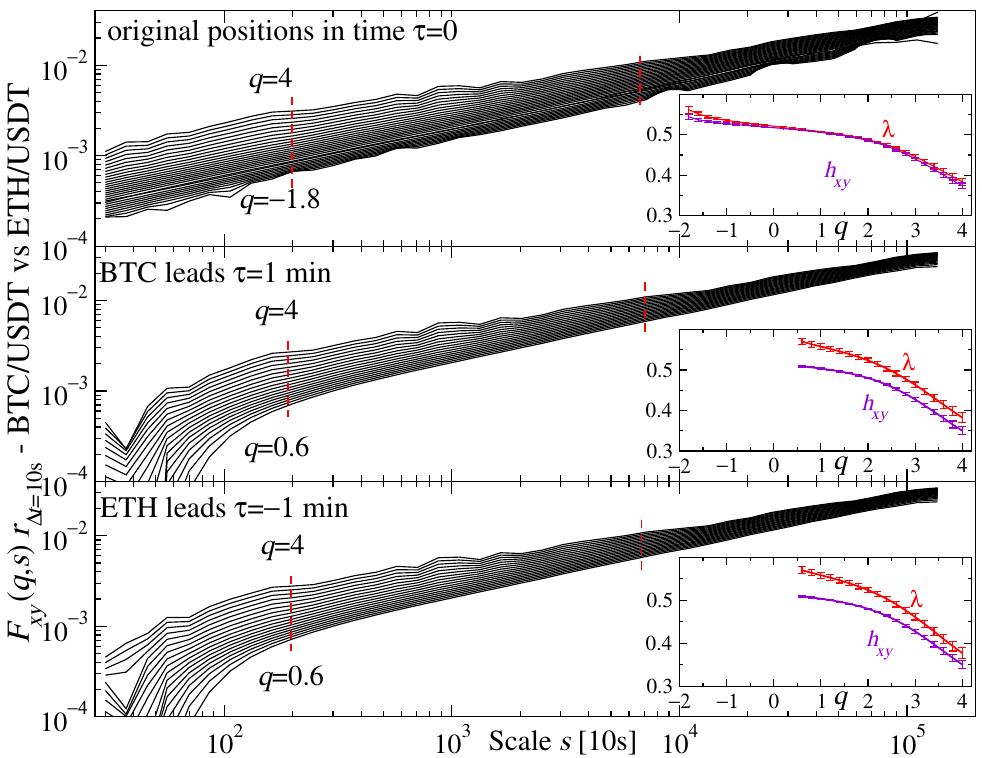
Figure 4. ( Main panels ) Fluctuation functions F XY q ( s ) calculated for the time series of logarithmic price returns r ∆ t ( t ) for X = BTC and Y = ETH. In each panel, vertical dashed lines denote a range ( s ) . Extreme values of q are also of time scales s for which a power-law model can be fitted to F q XY shown. Three cases are considered: both time series are simultaneous ( top ), time series representing BTC is advanced by τ = 1 min ( middle ), and time series representing ETH is advanced by τ = 1 min ( bottom ). ( Insets ) The bivariate scaling exponent λ ( q ) vs. the mean univariate scaling exponent h XY ( q ) calculated for the same time series. Error bars denote the standard errors. ( s ) for the time series that are The middle and bottom panels of Figure 4 present F XY q shifted relative to each other by τ = 1 min: either BTC leads by τ (middle) or ETH leads by τ (bottom). In both cases, we see similar power-law dependence over ∼ two decades, but for larger s than in the τ = 0 case. We consider this shift toward longer s as expected, because asset prices need time to build up the cross-correlations if they are weakened by the relative shifts. The bivariate and mean univariate scaling exponents shown in the insets reveal a gap between them that is largest for q < 1, while if q increases, both quantities gradually converge. Compare this with Figure 5b (top panel, green and red lines) for even better visibility. The plots for τ = 0 and τ = ± 1 clearly differ from each other: for the shifted time series, ρ q ( s ) is more variable than for the simultaneous ones. However, what is similar is that here, ρ q ( s ) also shows steeper growth for q = 2 than for q = 4—see Figure 5a (top panels, green and red lines). For q = 2, there is no visible difference between the results if either BTC or ETH leads (top left). This changes after we move to higher q s: for q = 4 there is a noticeable difference between the corresponding lines, with higher values of ρ q ( s ) if BTC leads. This difference, however, is much smaller that that between the results for τ = 0 and τ = ± 1. This result is somehow expected, because contemporary markets operate at scales that are much shorter than 1 min. However, due to the long-range temporal autocorrelation in volatility lasting up to a few trading days [44] even if we shift one time series with respect to the other by 1 min, the fractal structure of the detrended cross-correlations can still be observed for these time